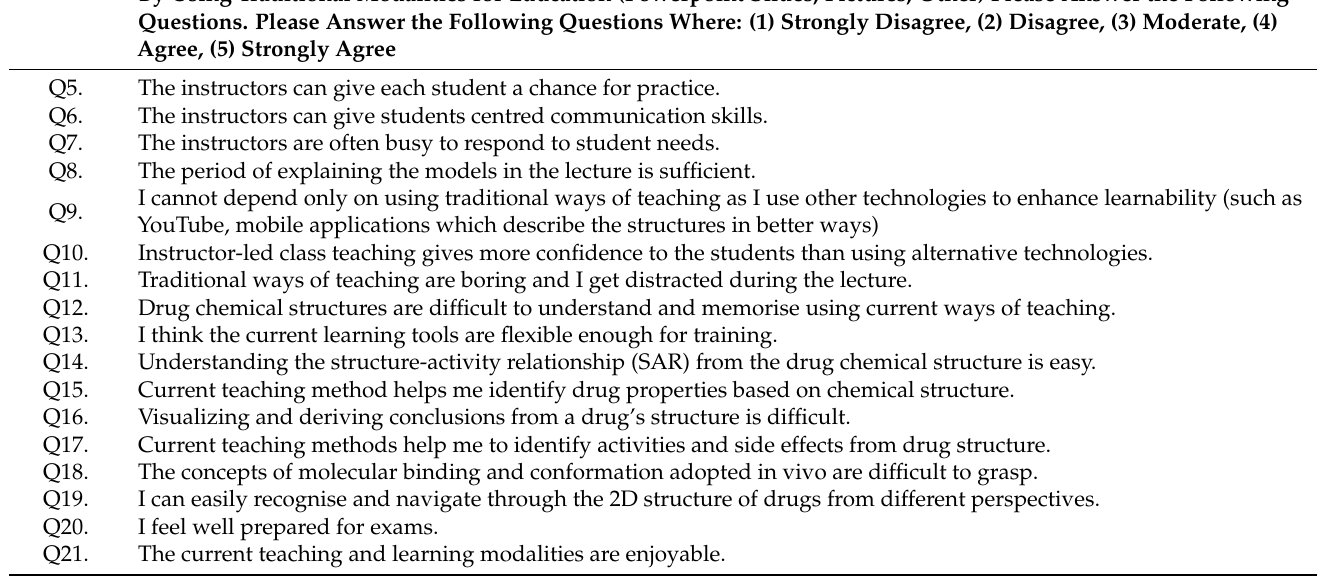
Table 3. Current educational modalities in the medical chemistry: Survey.